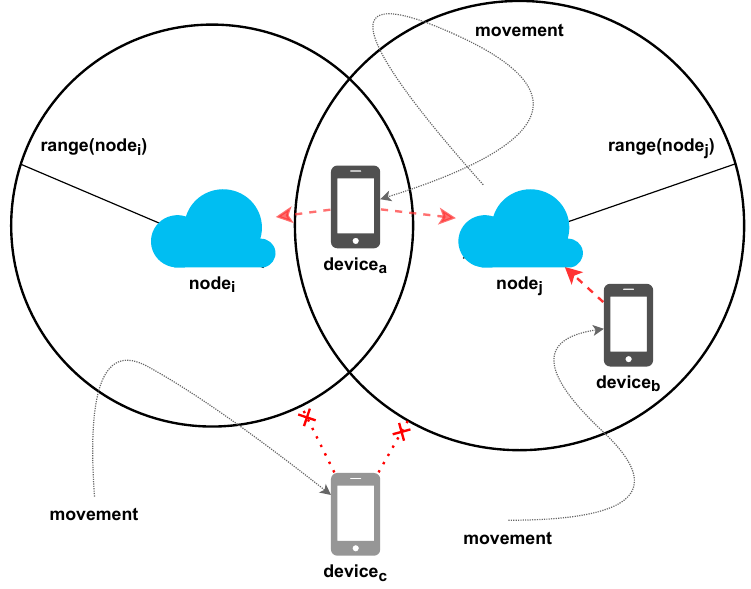
Figure 2. Limited internet access to smart